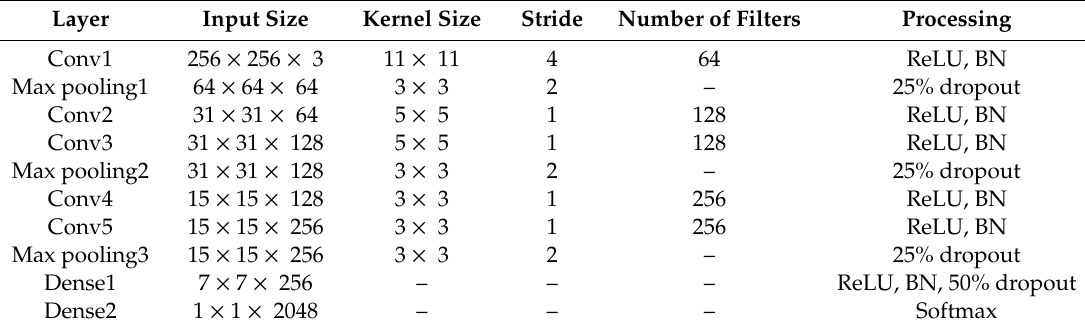
Table 6. Detailed structure of